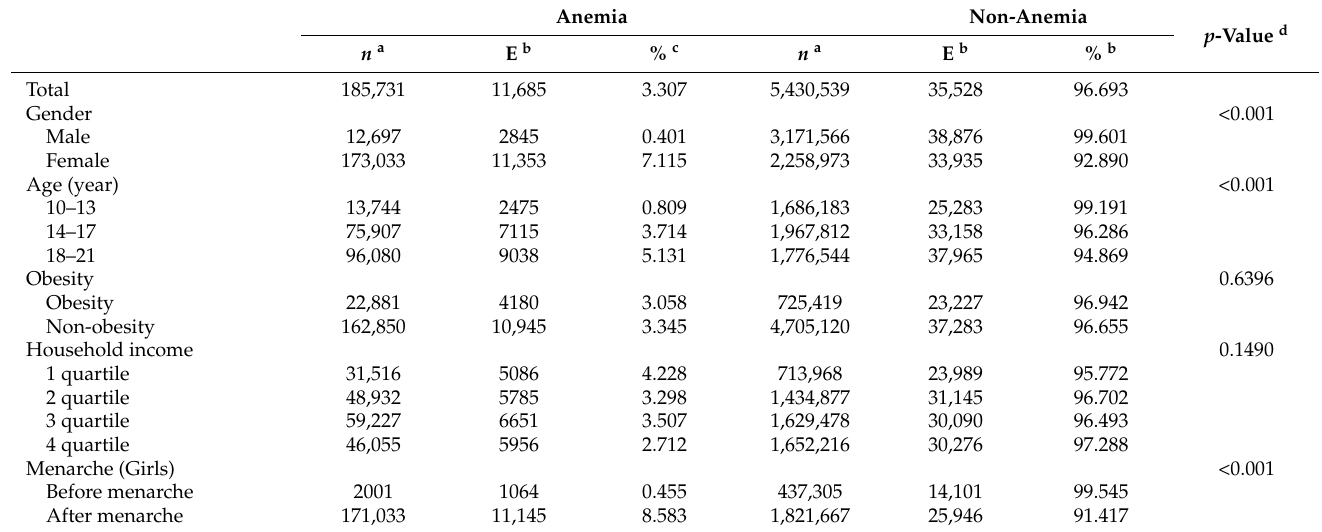
a Weighted sample size. b Standard error. c Weighted percentage. d Weighted p